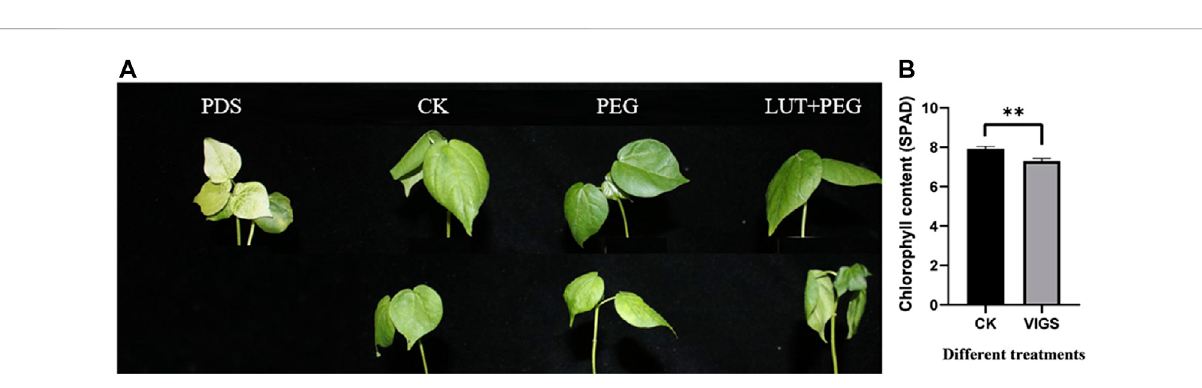
FIGURE 6 Silencing oftheupstreamsynthetic lutein gene GHLUT2 reduced drought tolerance of cotton (A) The upper partwas thenormal growth group of three-leaf cotton, and the lower part was the drought stress group, divided into three treatment groups, PDS, 156-CK, 156-PEG, LUT-PEG: PDS, 156-CK, 156-PEG, and rut-PEG. (B) Changes of chlorophyll content in cotton at 3 leaf